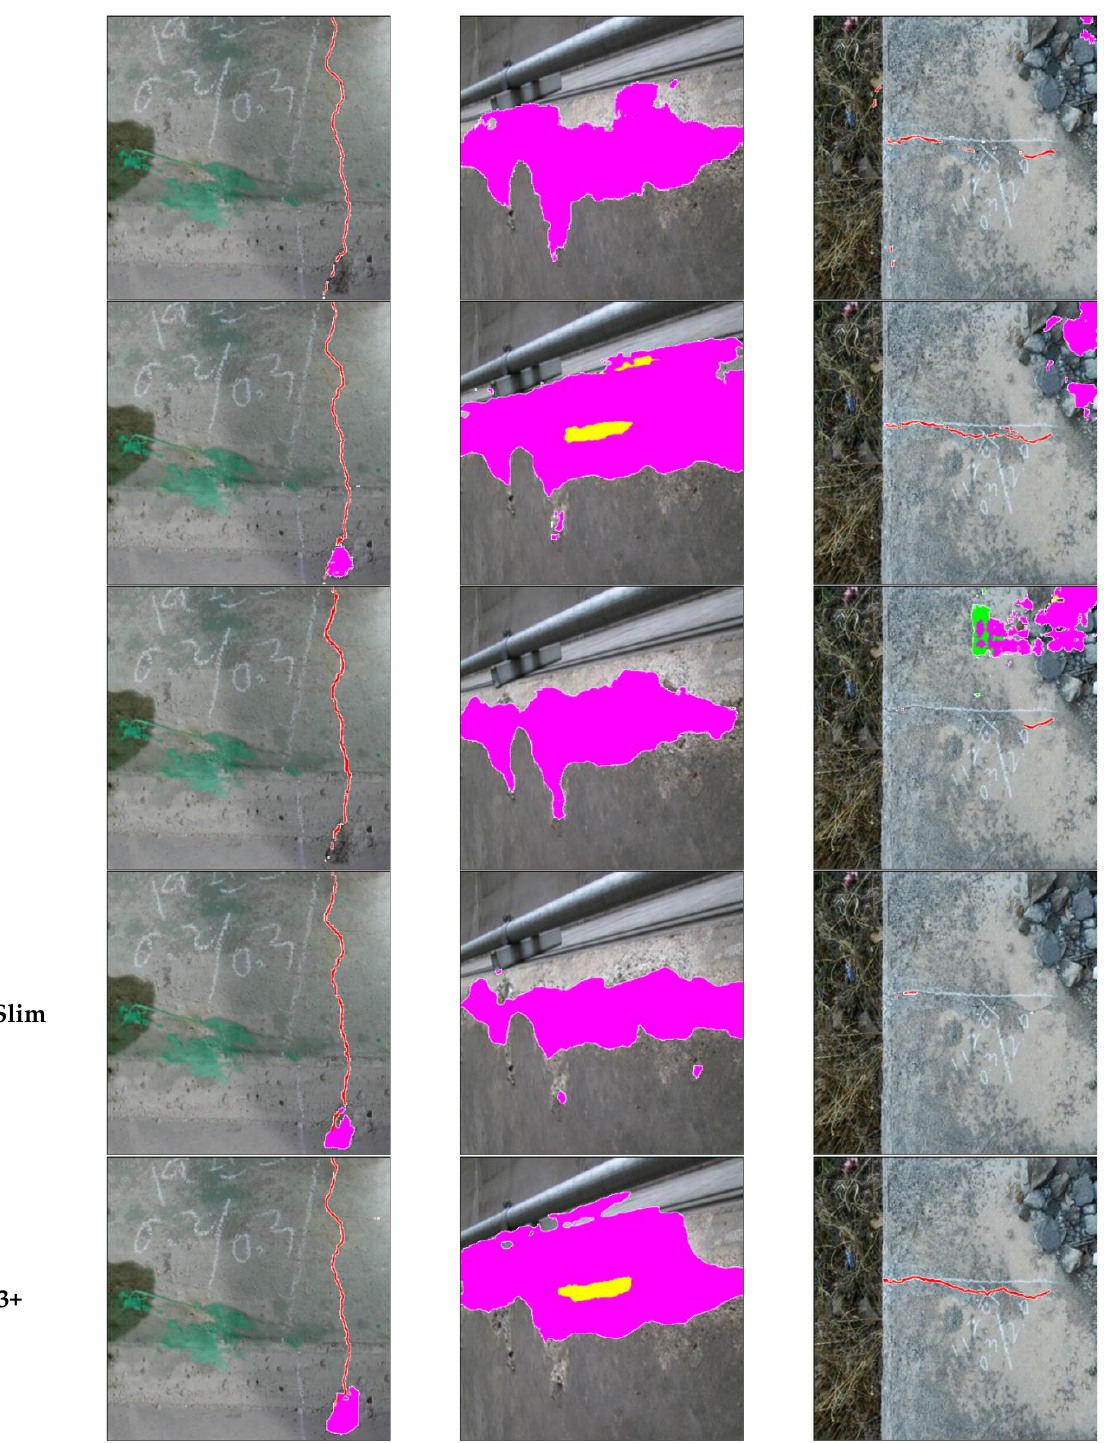
Figure 10. Example of prediction results of all models in complex background conditions.